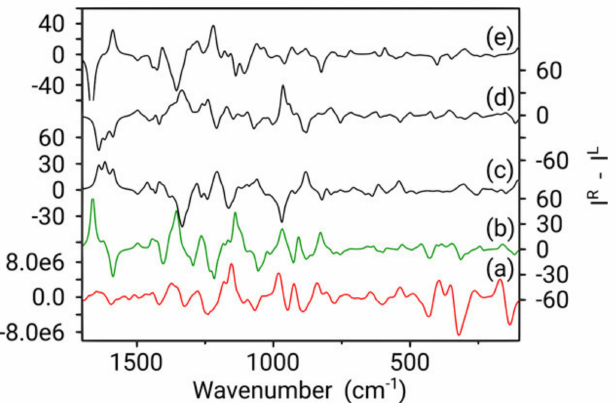
Figure 12. Boltzmann weighted calculated ROA spectra for 4a S ,6 R ,8a S ( b ), 4a S ,6 R ,8a R ( c ), 4a R ,6 R ,8a S ( d ) and 4a R ,6 R ,8a R ( e ), compared with the experimental ROA spectrum (measured in CHCl 3 ) ( a ). Y -axis labels are placed alternating left/right to avoid congestion. Reprinted with permission from ref. [51]. Copyright 2019 American Chemical